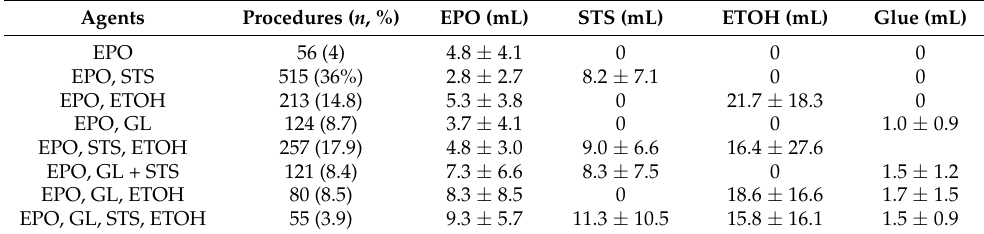
Table 1. Combinations and volumes of EPO and main